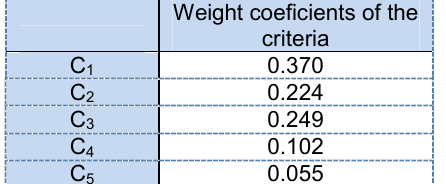
Table 7 – Final values of the weight coefficients Таблица 7 – Конечные значения весовых коэффициентов